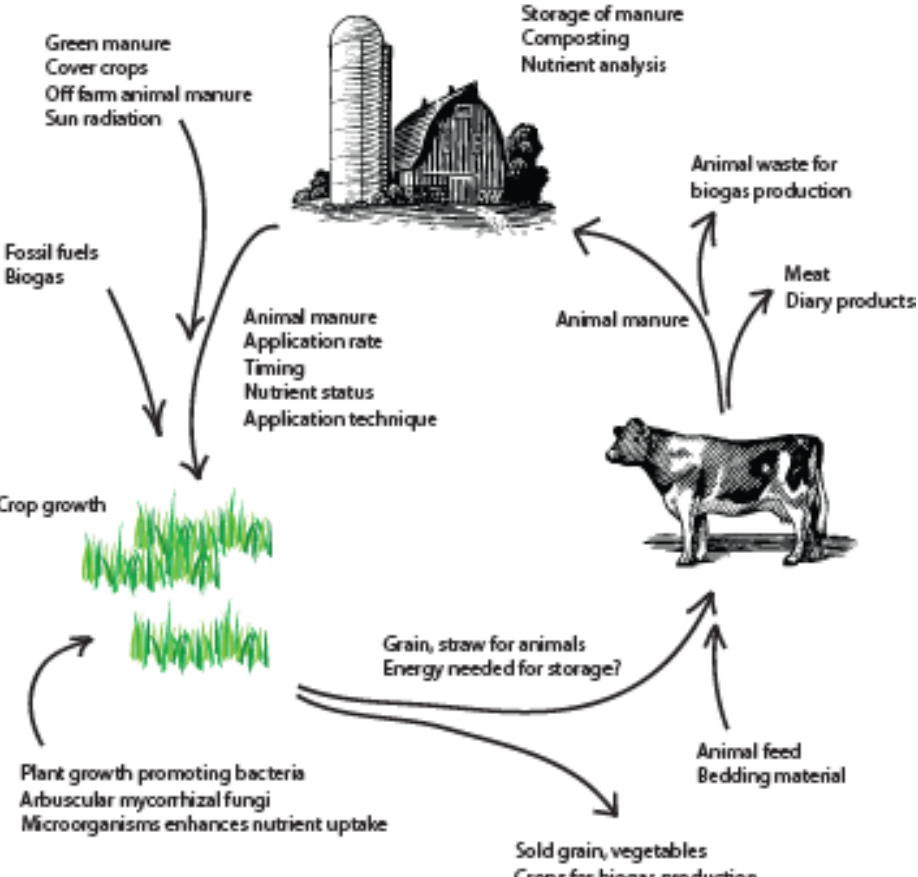
the process with respect to all parties involved in the production steps, thus ensuring an environment that can sustain our successors. Figure 1. Energy and nutrient re-cycling in organic farming. Animal feed and bedding material are needed in order to keep animals. The farmyard manure can then be stored, preferably composted to reduce the number of pathogenic bacteria, or used for biogas production. Nutrient analysis is an important step if the manure is to be used as a fertilizer. Other types of fertilizers that can be used are cover crops and green manure. If the farm does not keep animals, or cannot produce enough manure, off-farm manure is sometimes bought from near-by farms. The application technique as well as the timing and rate of application, are very important steps to consider to minimize nutrient leaching. Fuels used for the farming equipment is often of fossil origin, but could in the future consist of biogas, in order to minimize farm dependence on fossil fuels. Plant growth promoting bacteria and arbuscular mycorrhizal fungi can be used in crop production to enhance plant nutrient uptake and to minimize nutrient leaching. The crops produced may then be stored and sold to consumers or used as feed for the farmyard animals, thus closing the farm energy